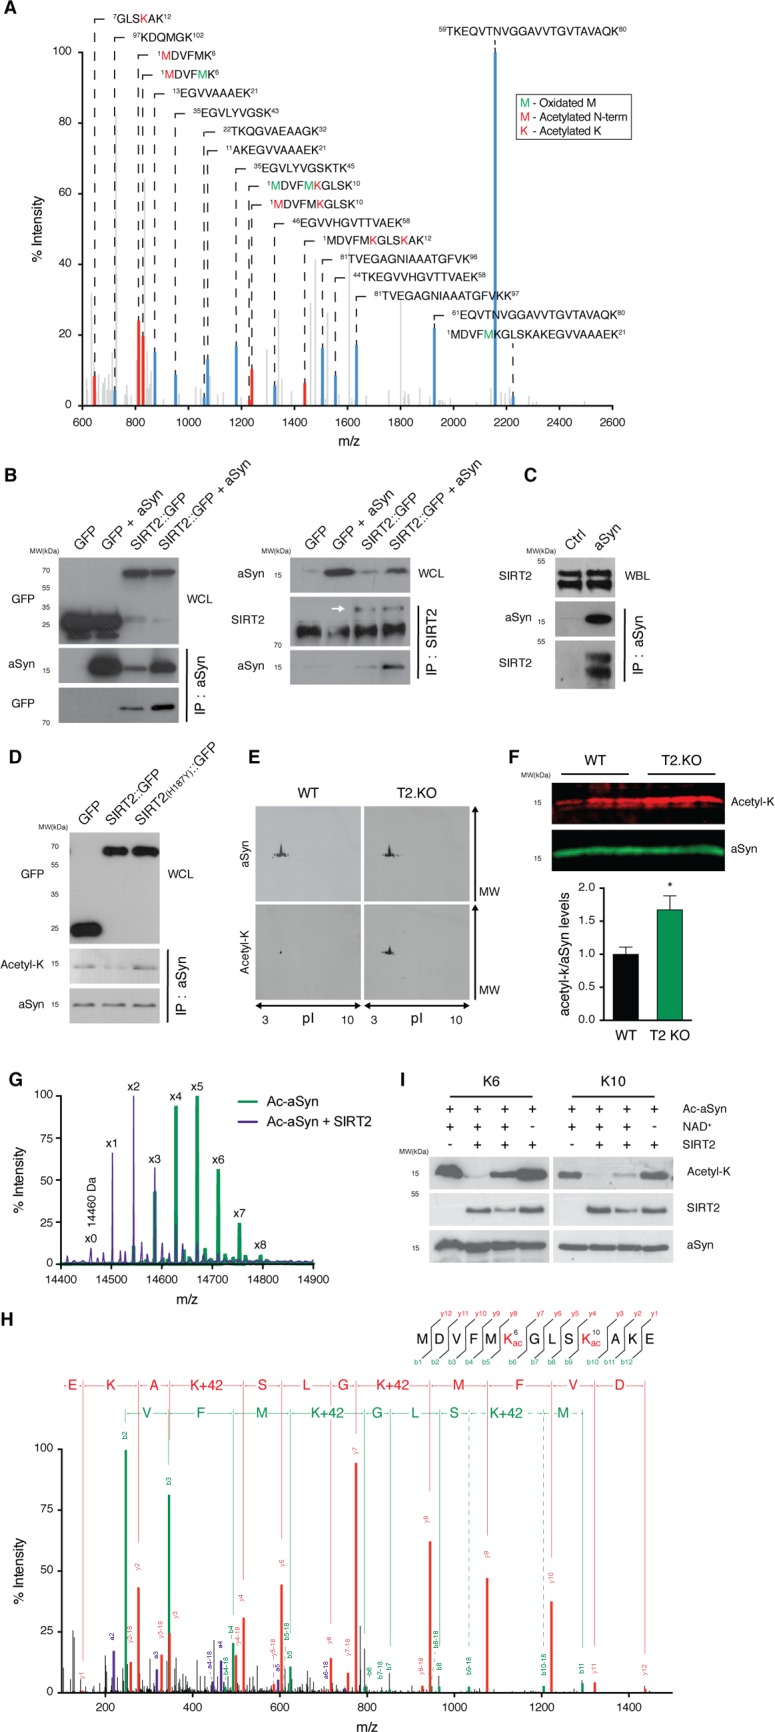
SIRT2 interacts with aSyn and deacetylates lysine 6 and 10.(A) Detection of aSyn acetylation on lysine 6 (K6) and lysine 10 (K10) by peptide mass fingerprinting analysis in total mouse brain lysates. Spectrum shows acetylated peptides in red and aSyn peptides in blue. The corresponding peptide sequences are shown (red residues are acetylated and green residues are oxidated). (B) Human HEK293T cells expressing the indicated proteins were lysed and immunoprecipitated (IP) with anti-aSyn (left panels) or anti-SIRT2 polyclonal antibodies (right panel). The whole-cell lysates (WCL) and immunoprecipitation samples were probed for GFP (left panels) or aSyn (right panels). (C) Mouse whole-brain lysates (WBL) were lysed and IP with anti-aSyn polyclonal antibody. The IP sample was probed with anti-SIRT2 and anti-aSyn. Rabbit IgG was used as a negative control for the IP sample. (D) Immunoprecipitations were probed with an anti–acetyl-lysine antibody in cells expressing either SIRT2 or the SIRT2-H187Y inactive mutant. (E) Immunoblot of thermoenriched aSyn from mouse-brain lysate probed for acetyl-lysine and aSyn. (F) Brain protein extracts from WT and SIRT2 knockout (T2.KO) mice were separated by SDS-PAGE and immunoblotted with antibodies against acetyl-lysine and aSyn (n = 3). The ratio of acetyl-lysine to aSyn is presented. *p < 0.05, unpaired t test with equal standard deviation (SD). (G) Overlay of the deconvoluted intact protein mass spectra obtained from chemically acetylated aSyn (theoretical mass 14,460 Da) in buffer (green) and treated with SIRT2 (purple). The observed masses of the different species correlate with the presence of multiple acetyl modifications (+42 Da), ranging from 2 to 8 before treatment with SIRT2 and from 0 to 6 after deacetylation with SIRT2. (H) Mass spectrometry fragmentation analysis of a peptide from aSyn carrying acetylations at K6 and K10. Red peaks correspond to y-ion series, green peaks to b-ion series, and purple peaks to a-ion series. Corresponding amino acids to mass intervals of y-ion and b-ion series are represented (red and green, respectively). (I) Semisynthetic aSyn acetylated at K6 and K10 were incubated with increasing amounts of recombinant SIRT2 in the presence or absence of NAD at 37°C for 3 h. Proteins were probed for acetyl-lysine residues, aSyn, and SIRT2. All images are representative out of three independent experiments. Data in S1 Data.